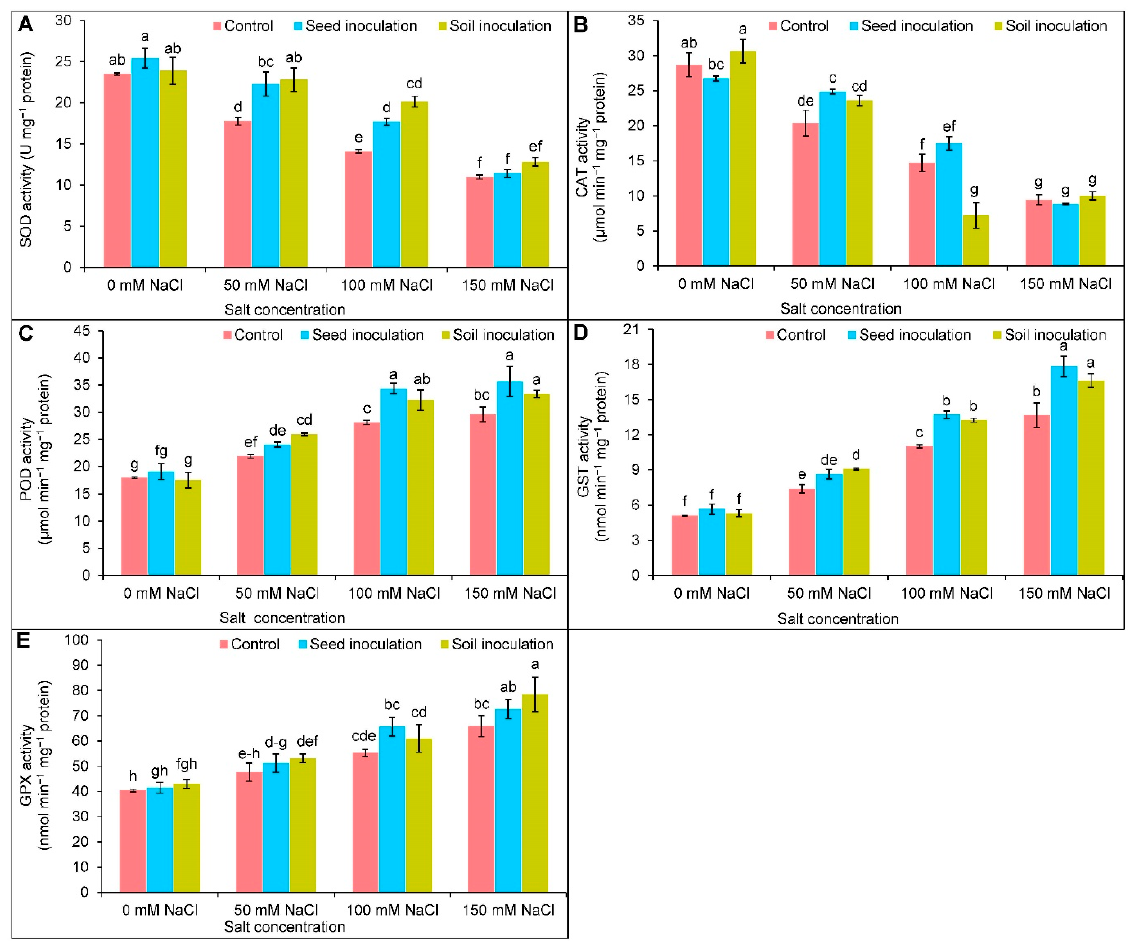
Figure 8. Effect of Bacillus subtilis in response to different concentrations of salt stress on the activities of SOD ( A ), CAT ( B ), POD ( C ), GST ( D ), and GPX ( E ) of soybean ( Glycine max cv. BARI Soybean-5). Values in a column are mean ± SD. Different letters on each bar indicate significant differences among the treatment after applying a Tukey’s HSD test at p ≤ 0.05.